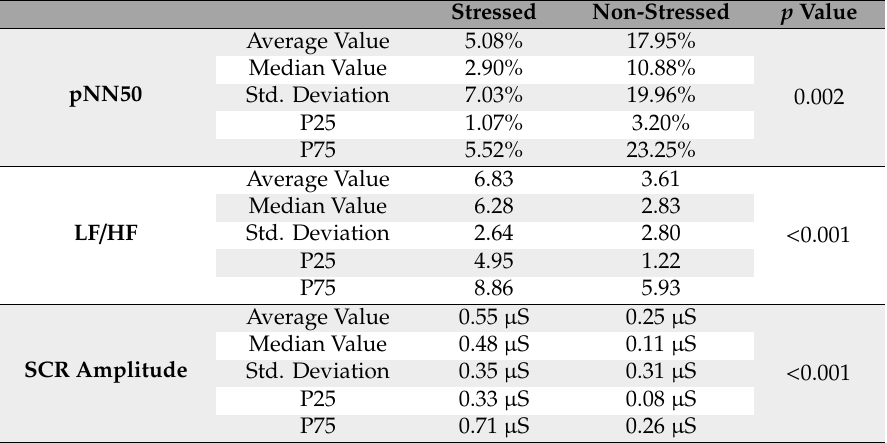
Table 6. Heart rate variability and skin conductivity during the driving test grouped by initial stress level.